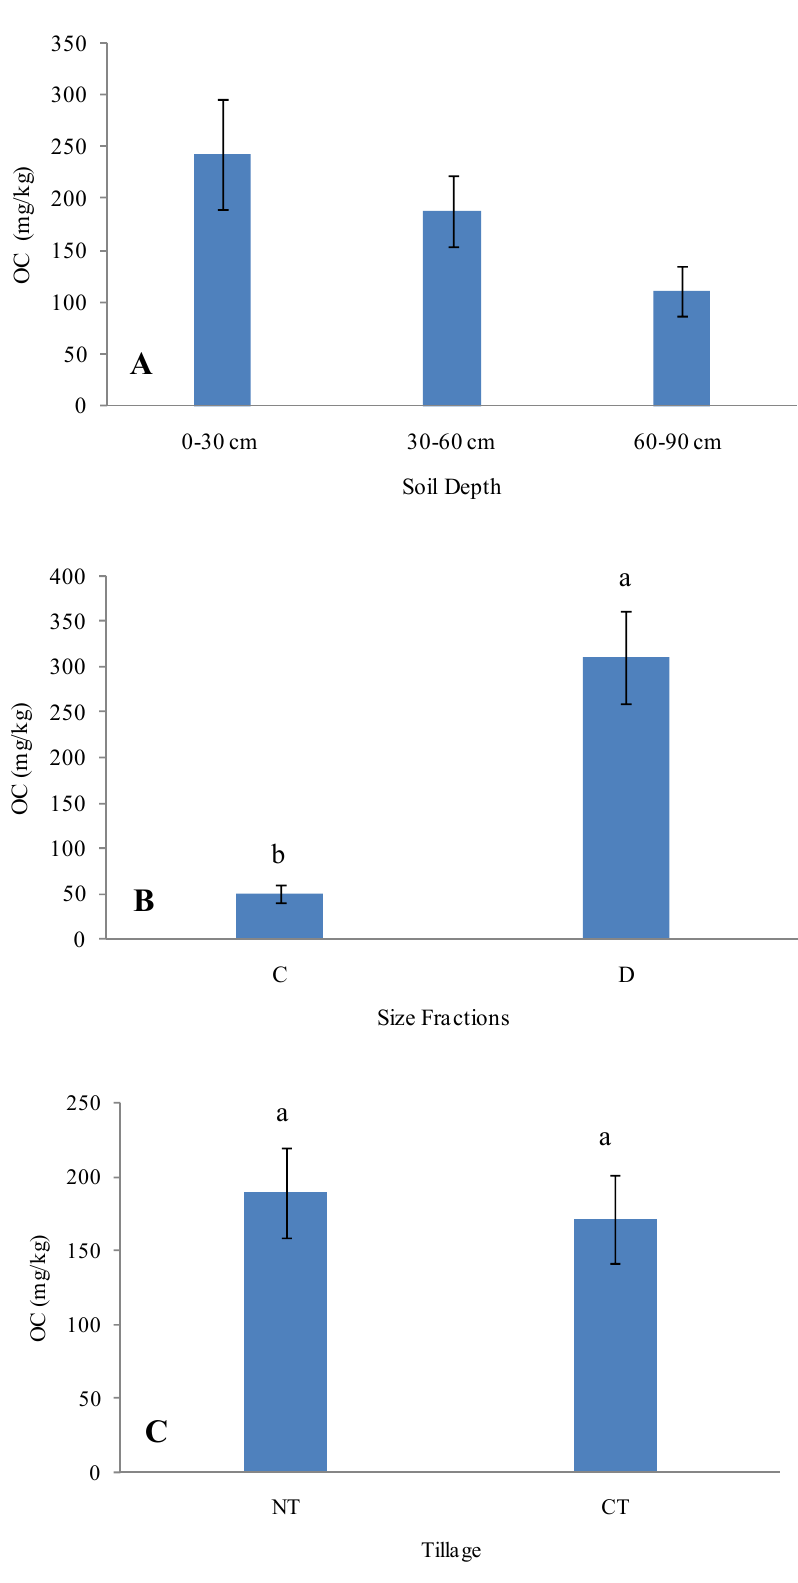
Figure 3. Concentration of organic carbon as a function of soil depth ( A ), size fractions ( B ) and tillage ( C ). Error bars indicate standard deviations of three laboratory replicates. Di ff erent letters indicate statistically significant di ff erences according to Tukey’s test at the 0.05